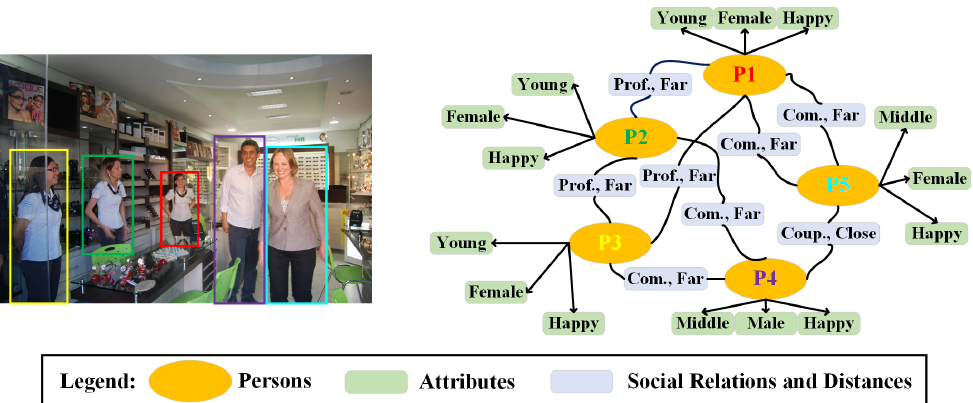
Figure 7. The social relation graph, depicting individuals, their low-level/high-level attributes and their social